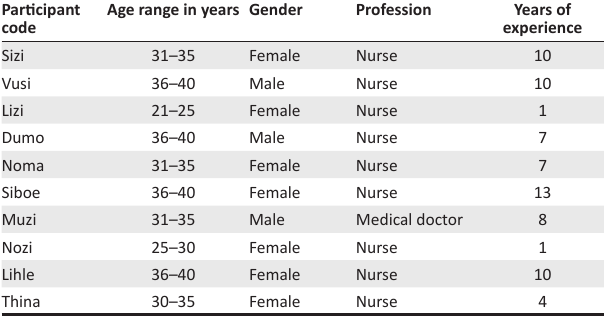
TABLE 1: Demographic data of the study